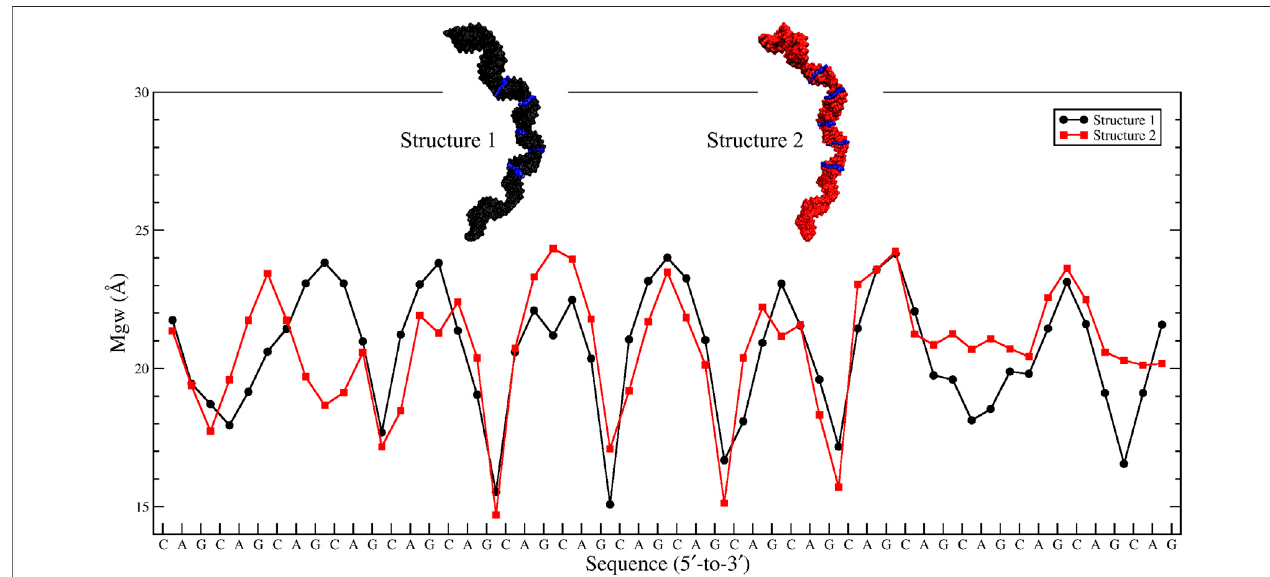
FIGURE3| Major-groovewidthanalysesofthetwomostbentclustersobservedin20×CAG.ChangesinMgwfromanaveragevalueof~20 Åto~15 Åinazigzag- like pattern, which create extremely bent conformations, are highlighted in blue in each